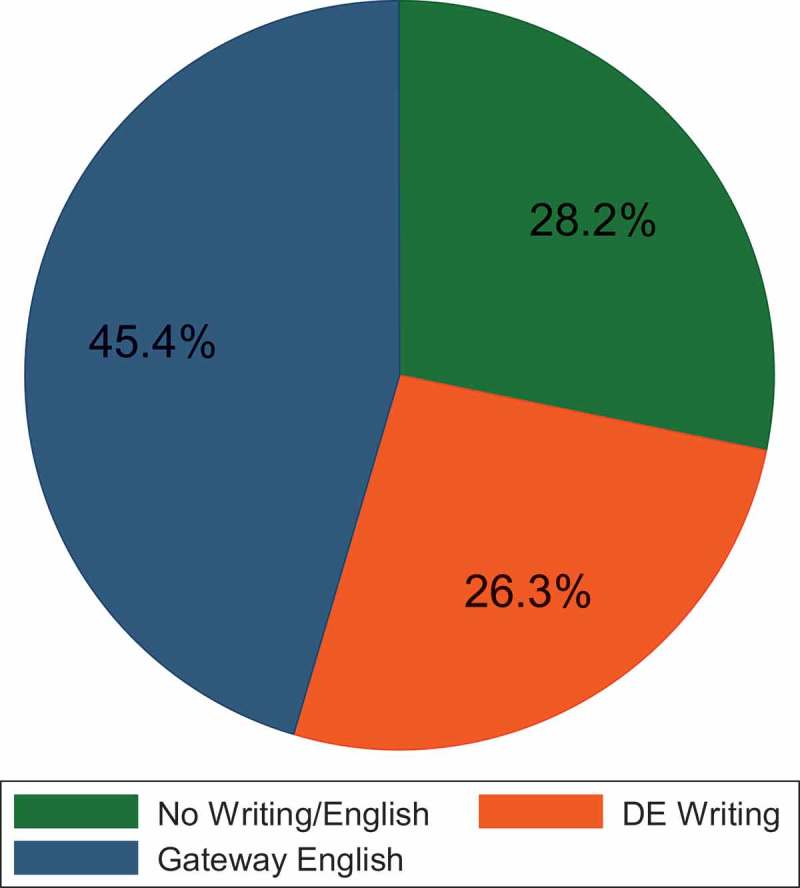
Writing/English enrollment pathways.